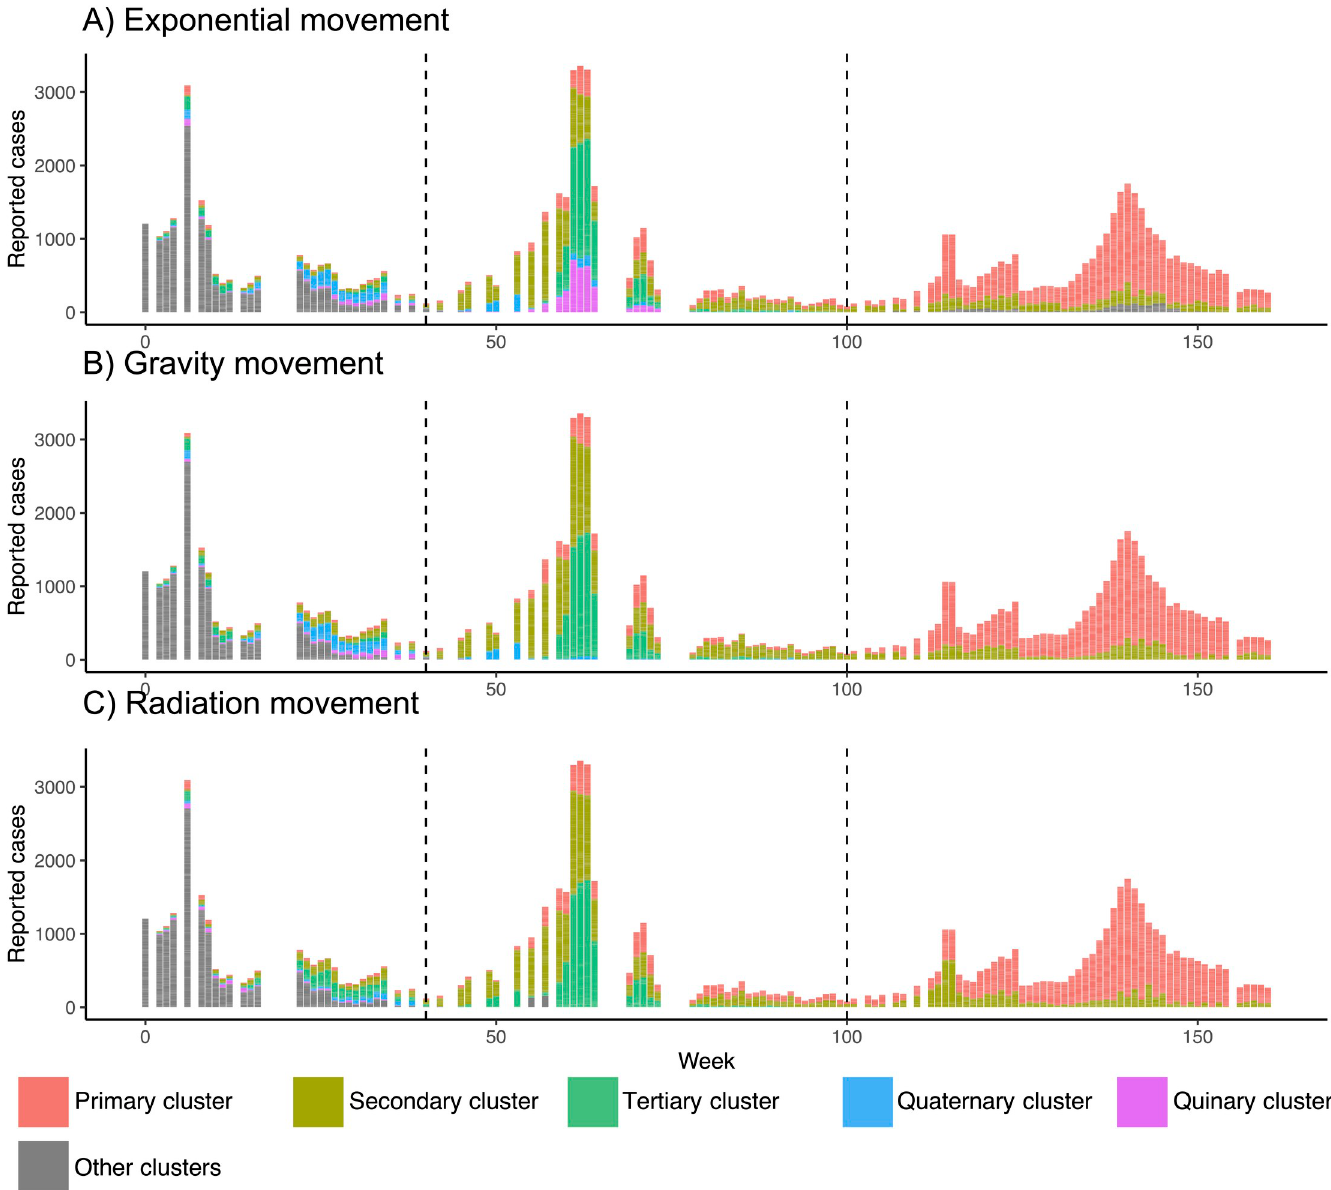
Fig 3. Top three identified case clusters according to exponential (A), gravity (B) and radiation (C) human movement models. Week 0 is May 2013. Only top 5 clusters shown. Dotted lines indicate the beginning of the 2014 and 2015